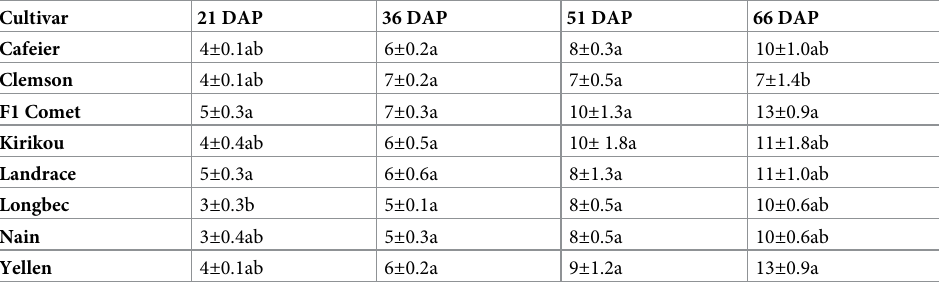
Values with the same letter in a column are not significantly different from each other under Tukey test at a 5% probability level.